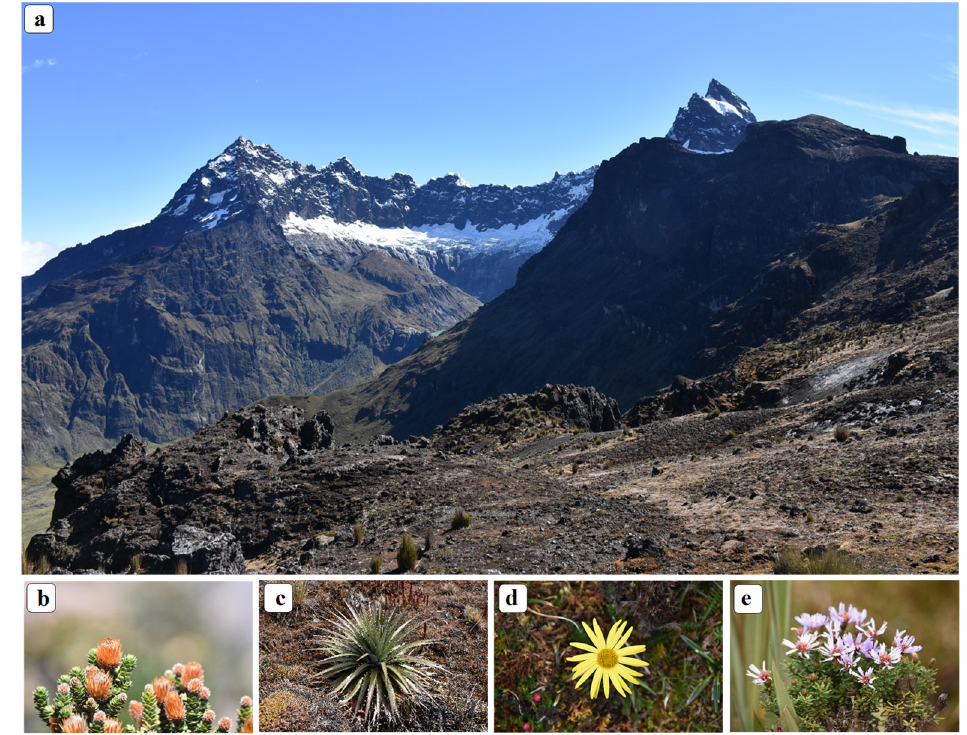
Figure 6. ( a ) Altar Volcano, ( b ) Chuquiraga jussieui , ( c ) Puya hamata , ( d ) Dorobaea pimpinellifolia , and ( e ) Silene acaulis .